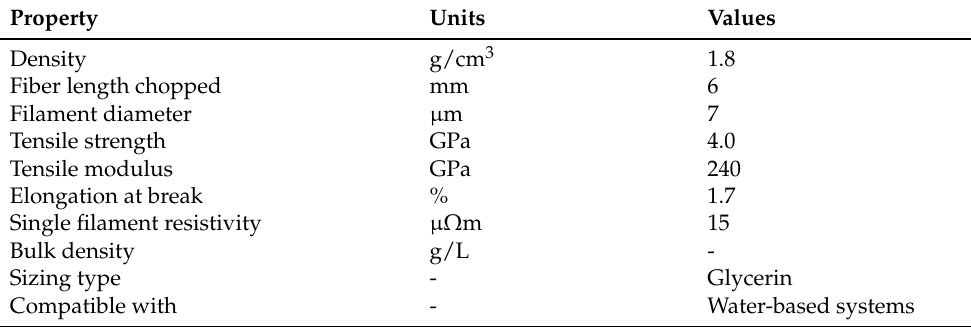
Table 2. Properties of carbon micro fibers adopted in the